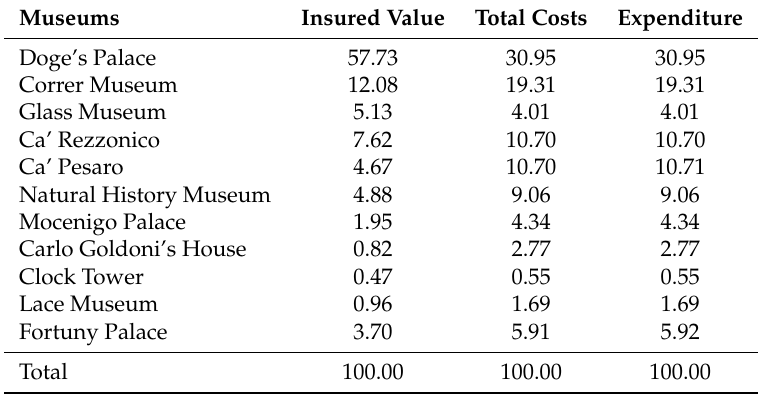
Table 4. MUVE museums: data on input variables (percentage